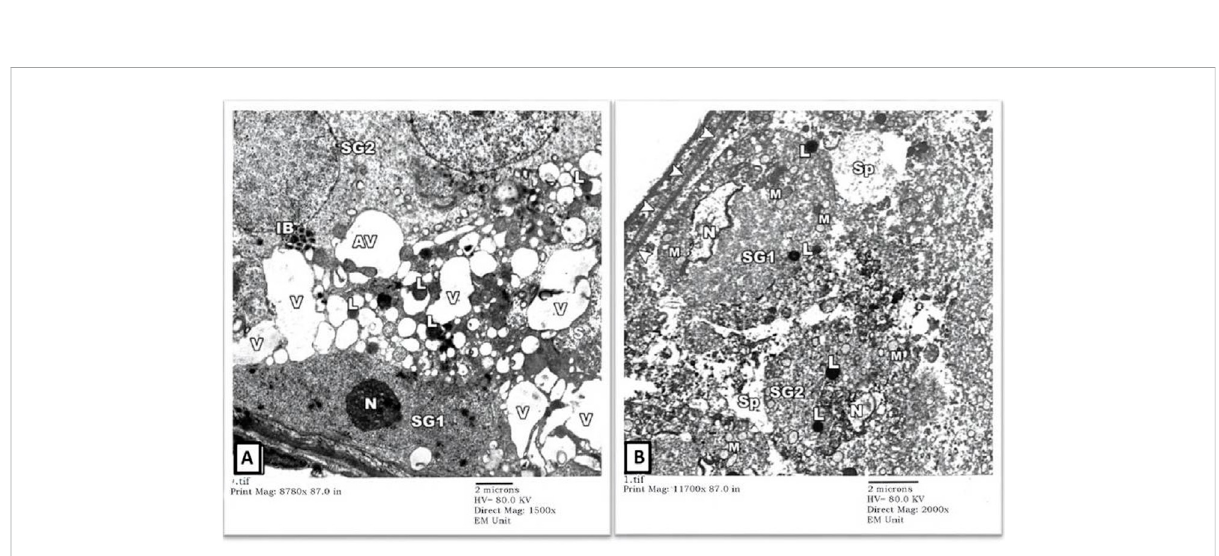
FIGURE 3 An electron micrograph ofaseminiferous tubule of thetestis froma ratin cadmium group showing: (A) aspermatogonium (SG1) resting on the basement membrane with pyknotic nucleus (N), corrugated nuclear membrane, and dense cytoplasm. The cytoplasm of the Sertoli cell houses variable-sized vacuoles (V) of the distorted sER as well as autophagic vacuoles containing mitochondria (AV) and lysosomes (L). The cytoplasm of another spermatogonium (SG2) contains variable-sized inclusion bodies (IB). (Uranyl acetate and lead citrate X 1500, Print Mag. X 8780). (B) a degenerated spermatogonium (SG1) resting on the basement membrane (arrowheads) with nuclear remnants (N), lysosomes (L), and swollen mitochondria lacking cristae (M). Another spermatogonium (SG2) shows an apparent shrinkage with a small distorted nucleus (N) and lysosomes (L). Necrotic debris is seen in the intervening spaces (Sp) between these cells. (Uranyl acetate and lead citrate X 2000, Print Mag. X